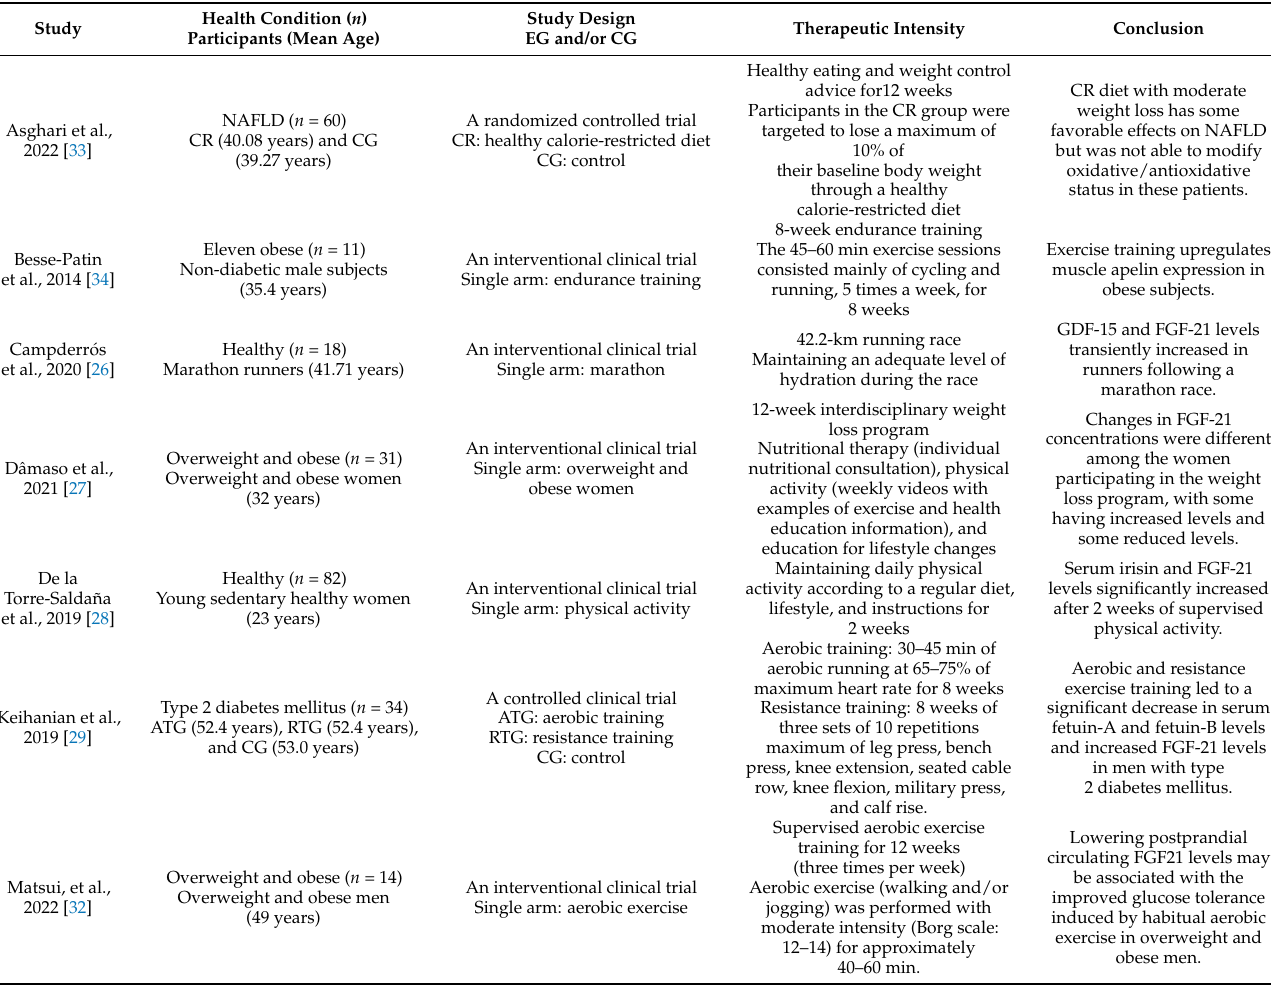
Table 2. Characteristics of included